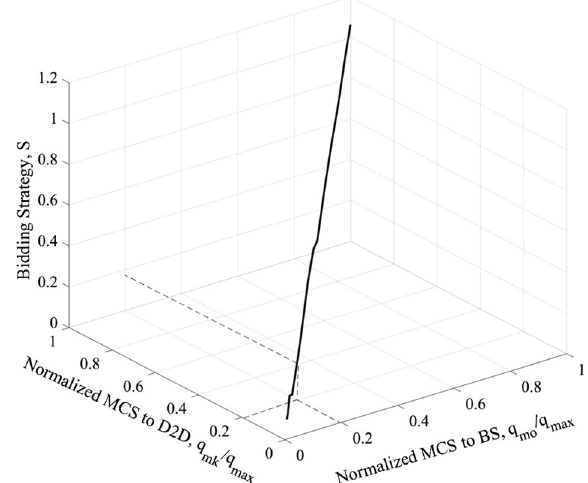
Fig. 6 An illustrative example of bidding strategy